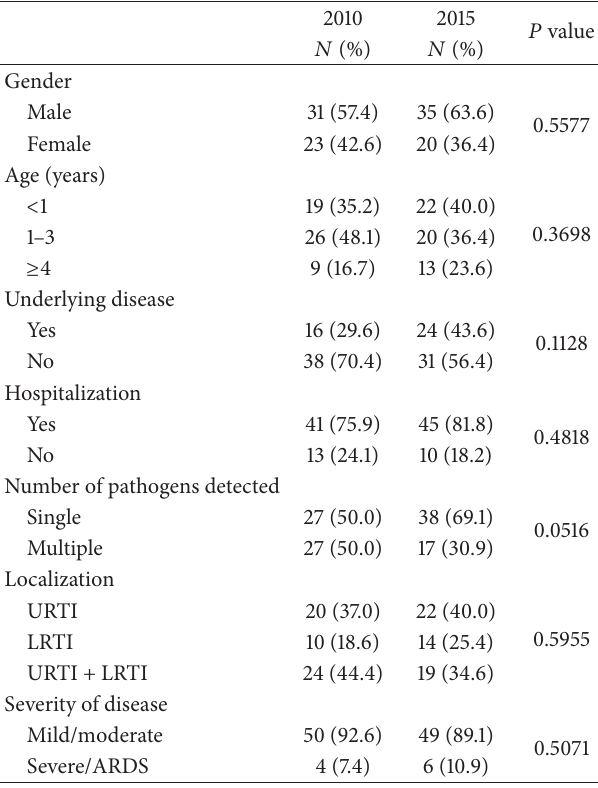
Table 1: Characteristics of patients with laboratory confirmed viral respiratory infection in 2010 ( 𝑁 = 54 ) and 2015 ( 𝑁 = 55